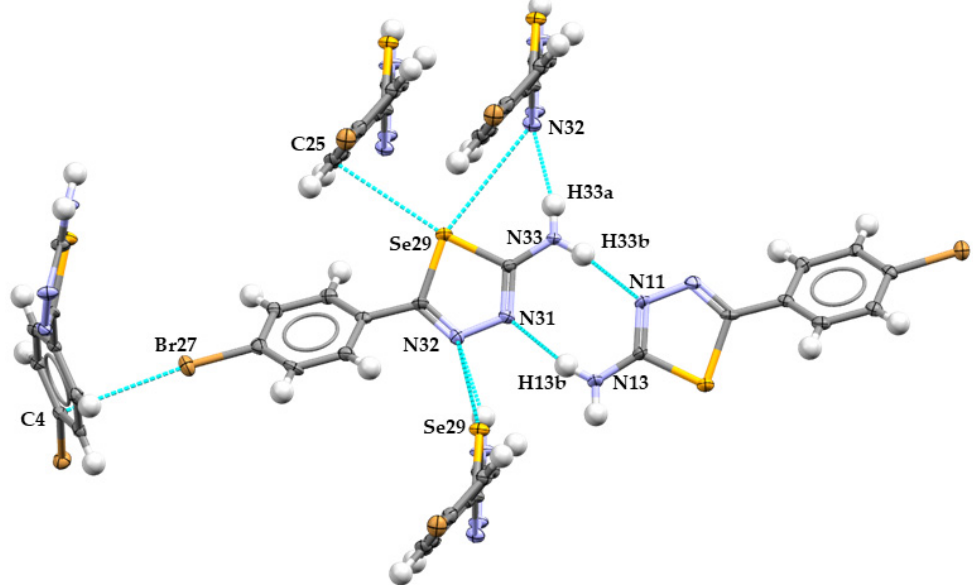
Figure 5. Primary intermolecular interactions in the crystal structure of T1-Se-Br. T1-S-I crystallized in two different polymorphs. Form I was obtained from acetoni- trile, and Form II from methanol. The polymorphs had different numbers of symmetry- independent molecules (Z’) and completely different intermolecular connectivity. Form I resulted in Z’ = 4, where all of them displayed closely related intermolecular connectivity but with different bond geometries (Figure S2). Two molecules in the asymmetric unit formed Type II halogen bonds that formed with the electrophilic area on one halogen atom with an electron-rich area on the other halogen. In this halogen bonding, the halogen atom simultaneously acted as both the donor and acceptor and the other two unique molecules did not show any halogen bonds. The sulfur atoms engaged in chalcogen bonds between S ··· N in which the nitrogen atom acted as a chalcogen-bond acceptor as well as a hydrogen-bond acceptor, indicating that the hydrogen bond was most likely the prominent interaction. In addition, two hydrogen bonds per molecule were formed between NH ··· N (Figure 6), leading to a 2-D chain-like assembly (Figure